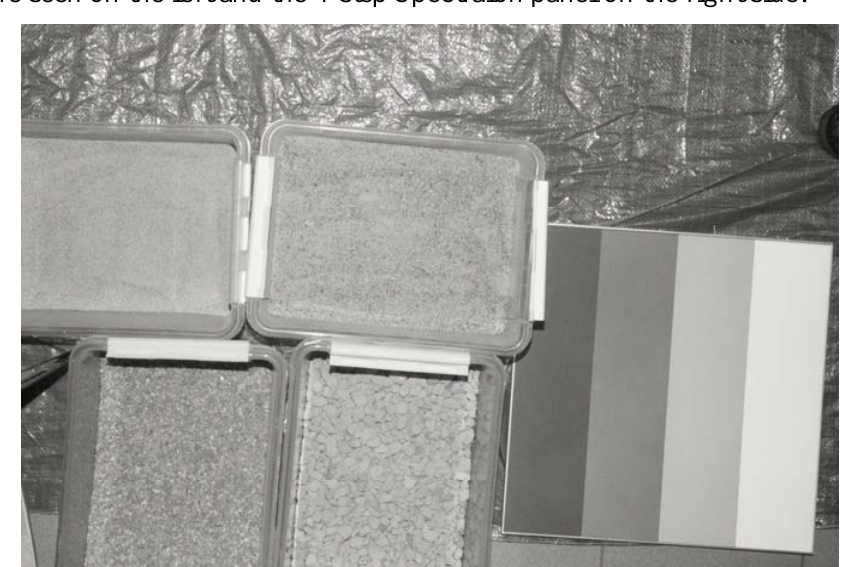
Figure 2. A Fuji camera NIR-image of the samples, taken from the scissor lift. The gravel samples are seen on the left and the 4-step Spectralon panel on the right